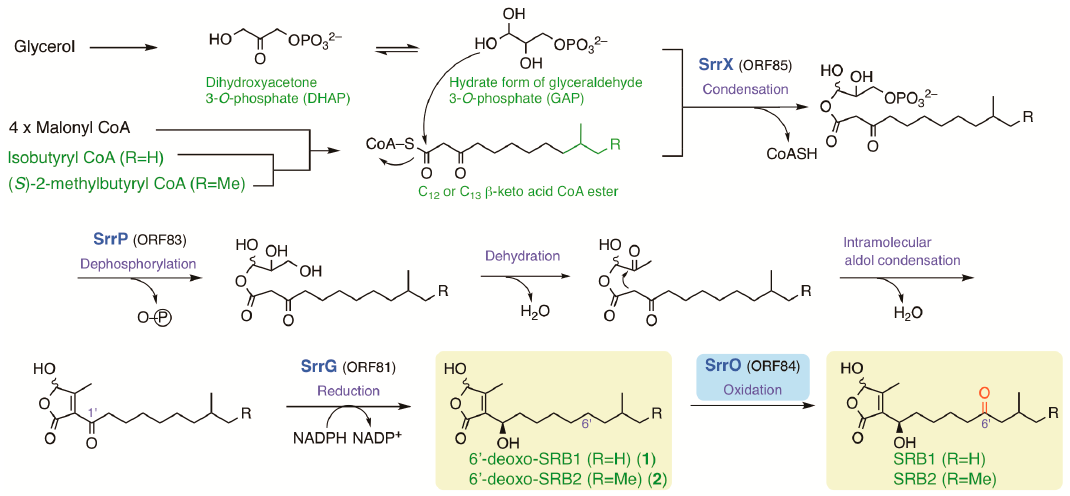
Figure 7. The possible biosynthetic pathway of SRBs in S. rochei . Me; methyl.